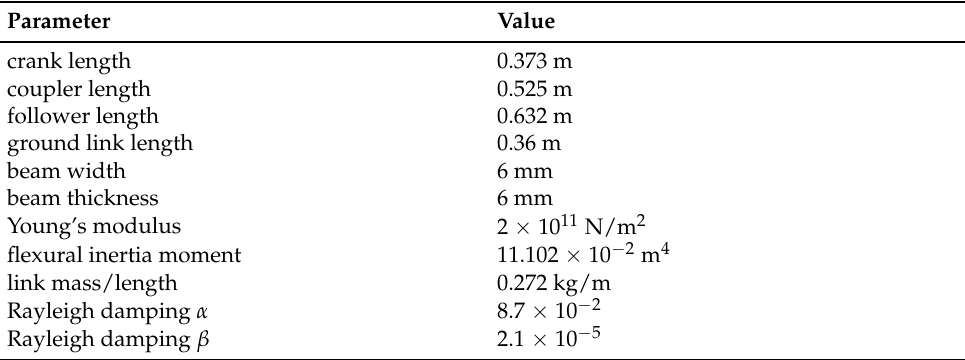
Table 1. Mechanical parameters of the flexible